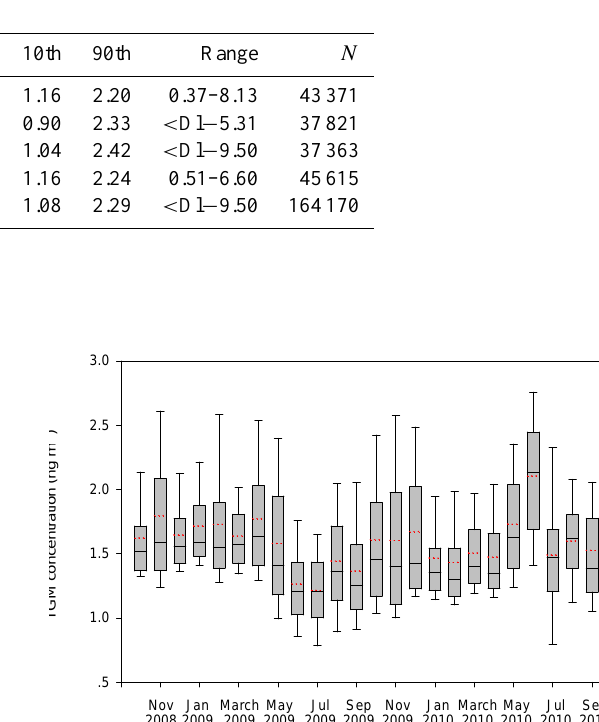
Table 1. Summary of TGM concentrations (ng m − 3 ) at CBS.